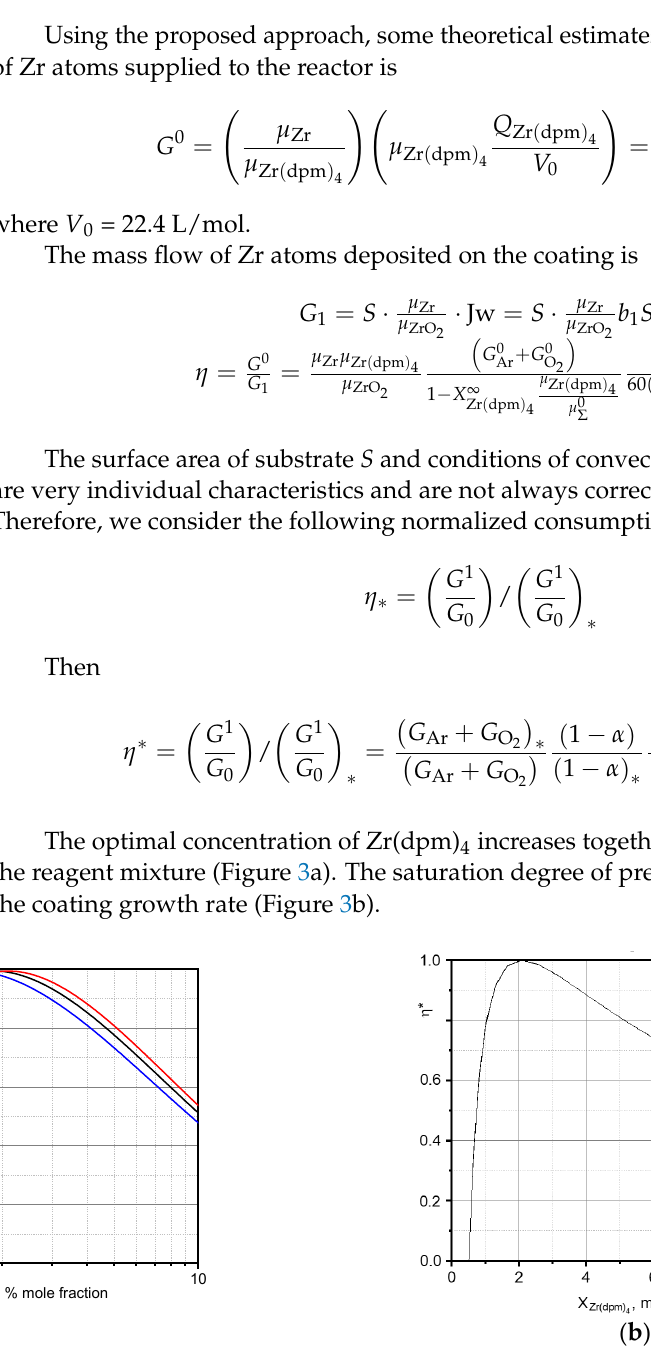
Figure 3. Optimum conditions for coating deposition depending on the precursor mole fraction. ( a )–the effect of oxygen content; ( b )–the effect of the degree of saturation of the precursor